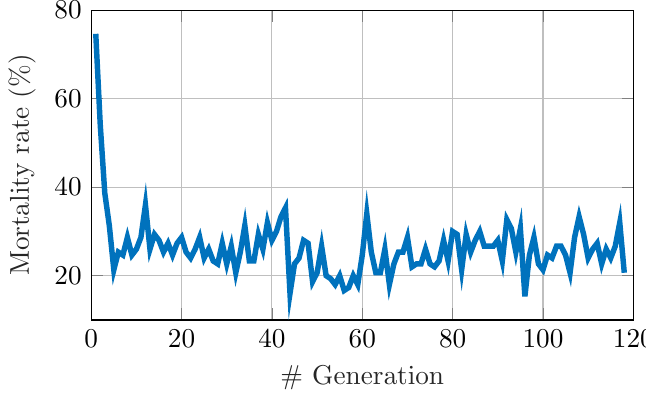
Figure 9. Mortality rate for the capital expenditure (CapEx) over productivity (CoP)-driven optimisation. Excluding the first two generations, the average is 25.5% and the standard deviation is